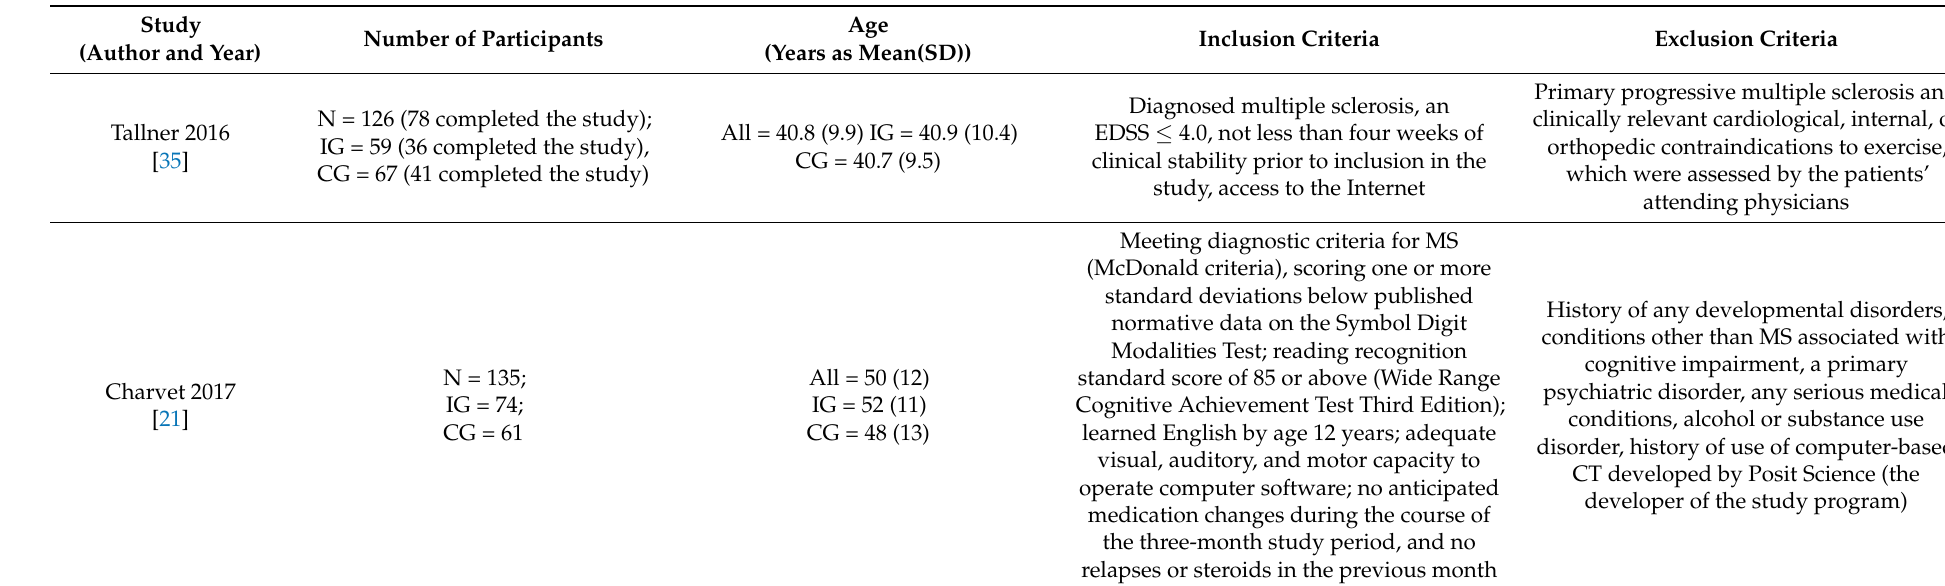
Table 4. Characteristics of research participants in studies of new technologies and other health- related outcomes in MS